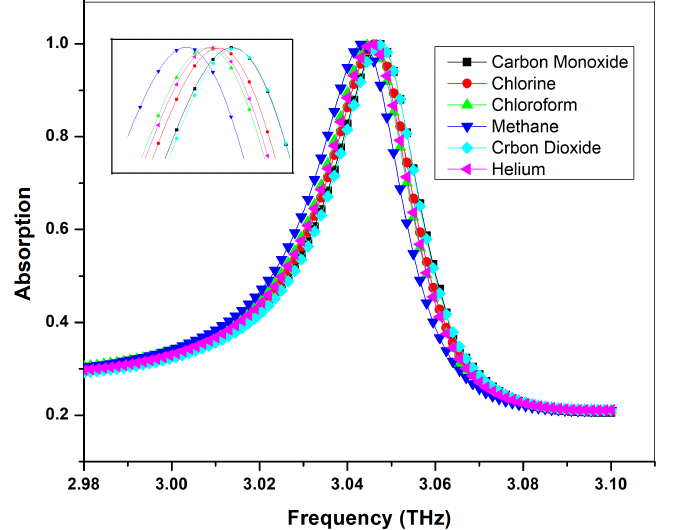
Figure 17. Absorption vs Frequency for carbon monoxide, chlorine, chloroform, methane, carbon dioxide, and